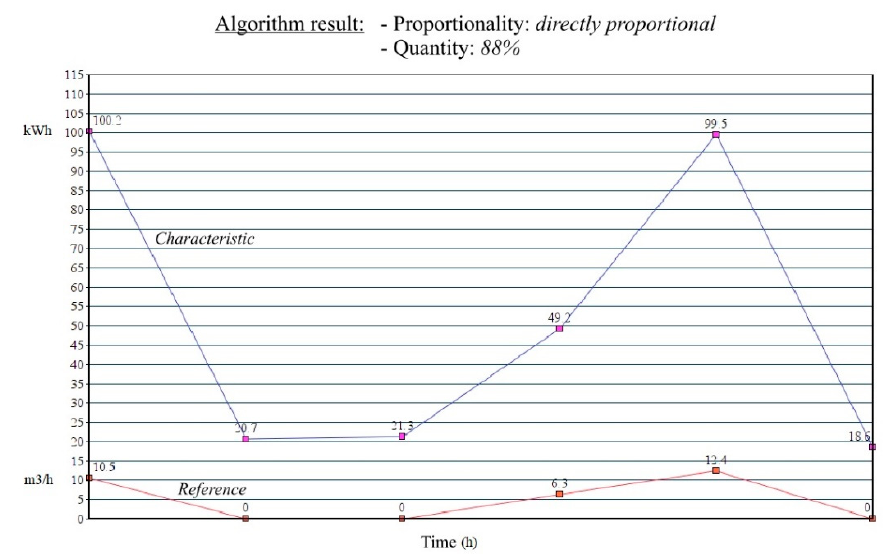
Figure 6. Test case graphical representation.